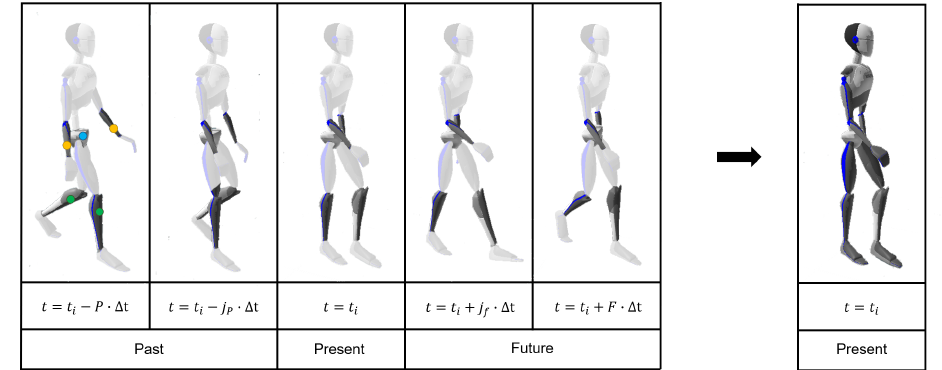
Figure 1. A sequence of inputs (lower arm (orange circle) /leg (green circle) orientations relative to the pelvis (blue circle) is used to estimate a single output pose (at time i ). Size of the input sequence can vary by the number of past ( P ) and future ( F ) poses that are taken into account and the distance in time ( ∆ t ) between the different inputs. Here, j p and j f are used as counters for the past/future poses in time, which have a maximum value of P and F (in this example, P = 2 and F = 2) , respectively. In other words, j p = { 1,..., P } and j f = { 1,..., F } , and ∆ t is defined as I / f s with I as the sample interval and f s as the sampling